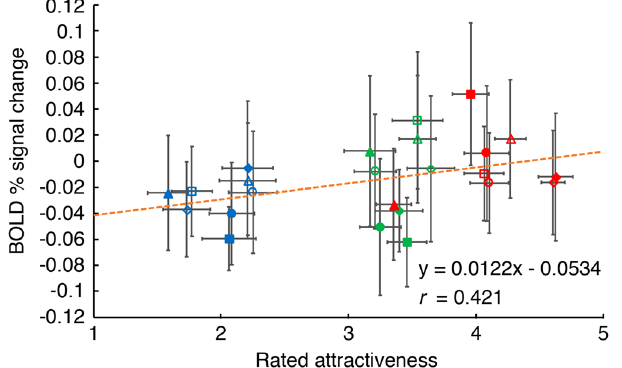
Figure 4. Relationship between rated attractiveness and activation in mOFC. Error bars indicate ± 1 SEM across